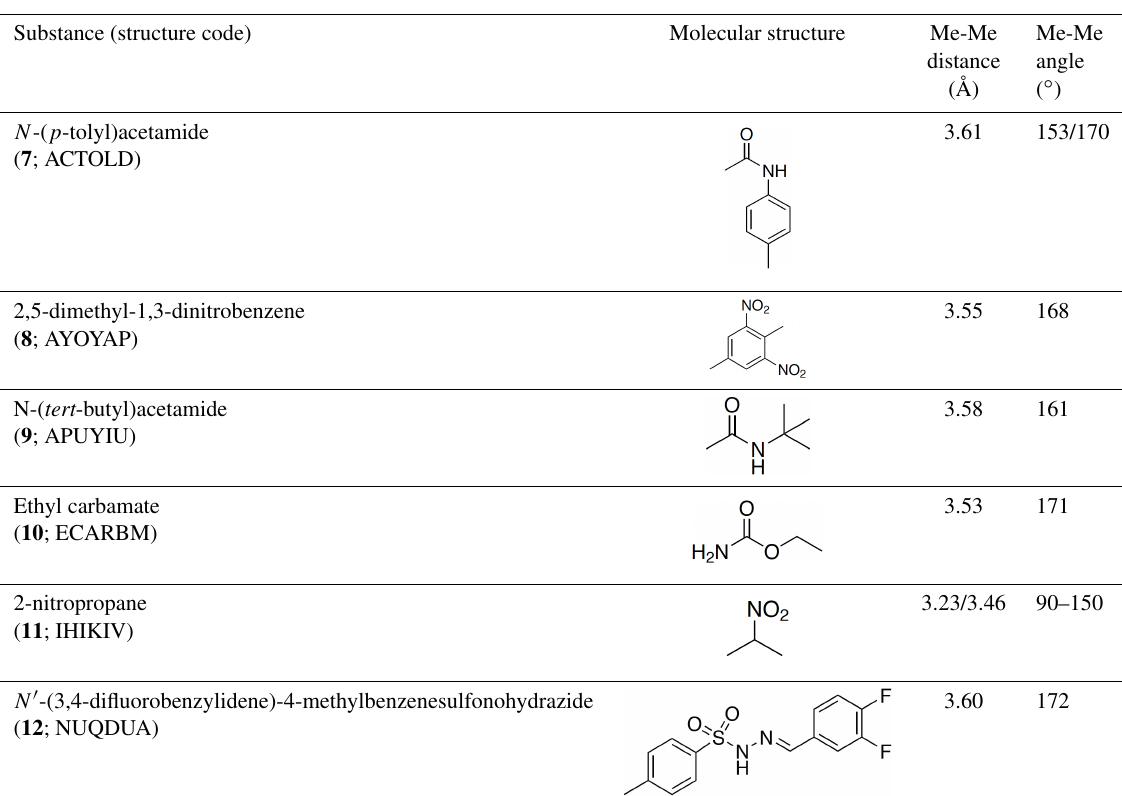
Table 4. Investigated compounds ( 7 – 12 ) from the systematic crystal structure search. Methyl-methyl (Me-Me) distances were measured carbon to carbon, and angles between methyl groups were measured along the path from quaternary carbon via methyl carbon to the methyl carbon of the neighbor molecule. The crystal structure data were obtained from the Cambridge Structural Database (CSD). In addition to the name of the substance, the crystal structure code is given in